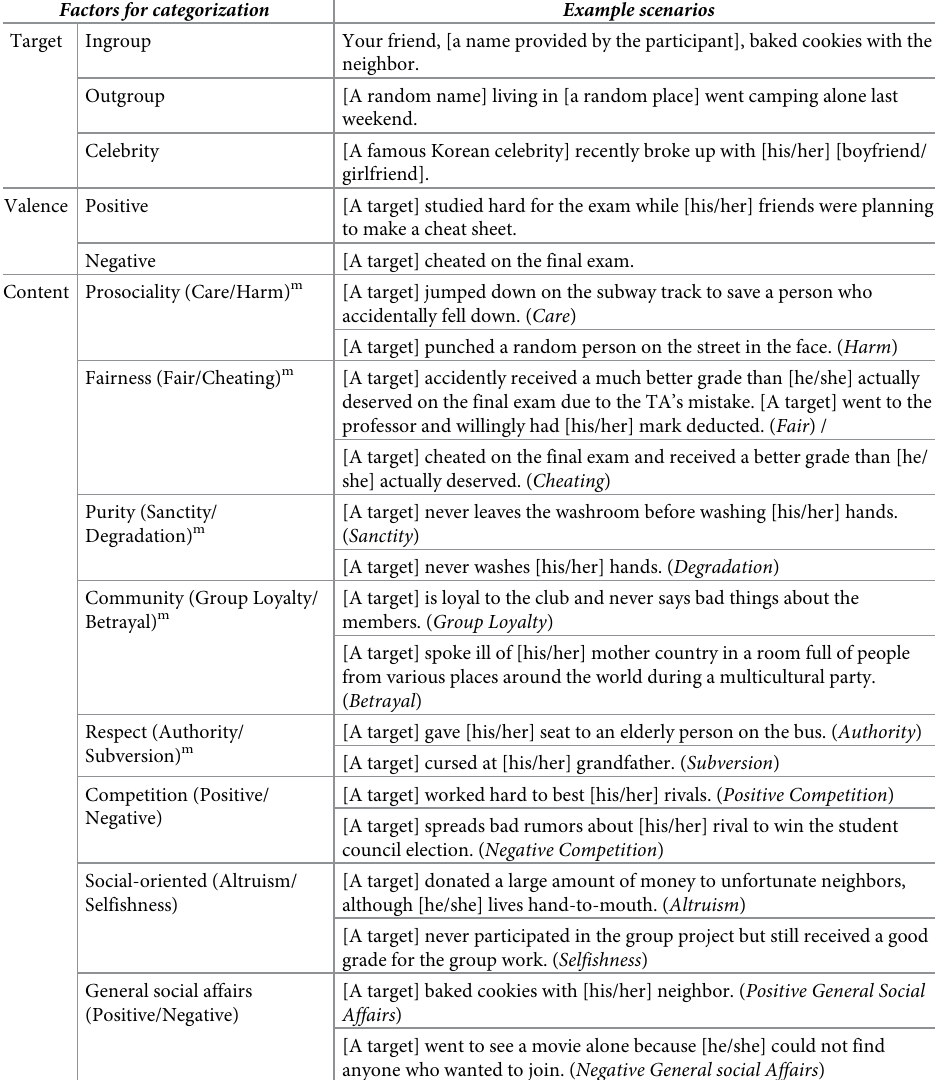
Table 4. Gossip categorization and examples. Contents with superscript “m” contain moral aspects based on the moral foundations theory